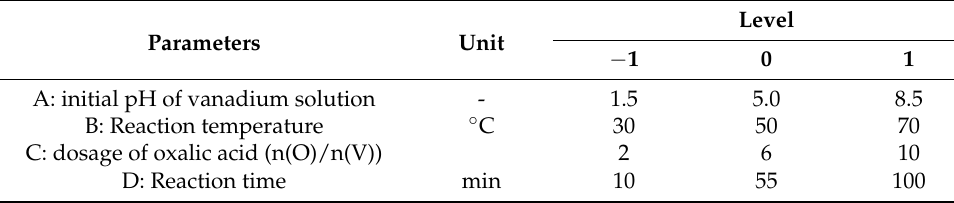
Table 1. Parameters and level values.